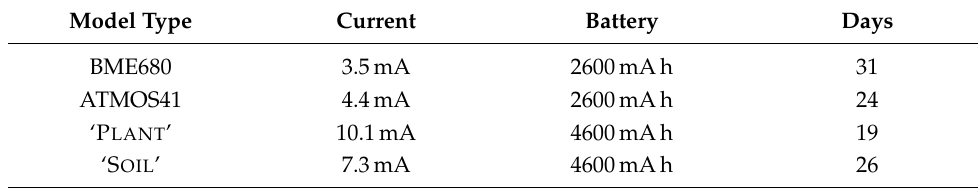
Table 2. Module power